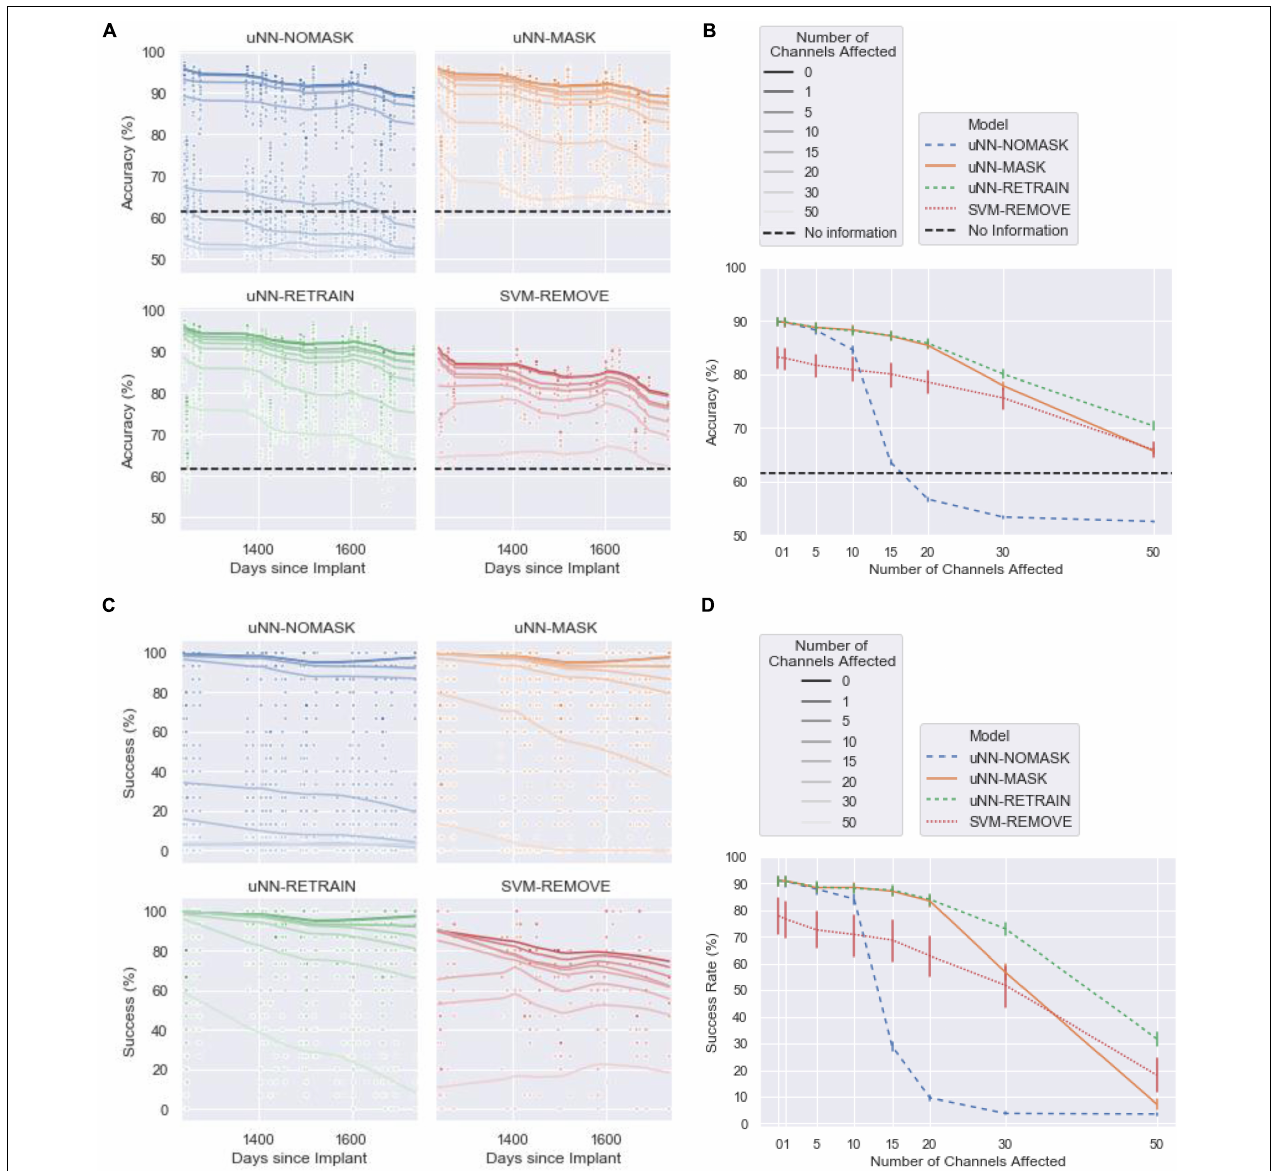
FIGURE 3 | The performance of the decoders with increasing numbers of channels affected by corruption. Simulated damaged was introduced on the first day of the test set. The uNN-NOMASK, uNN-MASK, and uNN-RETRAIN were tested over 10 different random initializations, while only one SVM was tested for each day and number of channels affected. (A) The accuracy over the 1.4-year test period. (B) The mean accuracy across 100-ms time bins as a function of the number of channels dropped. Error bars represent 95% confidence intervals. (C) The success rate over for each 2.5 s cue over the 1.4-year test period. (D) The mean success rate across 100-ms time bins as a function of the number of channels dropped. Error bars represent 95% confidence